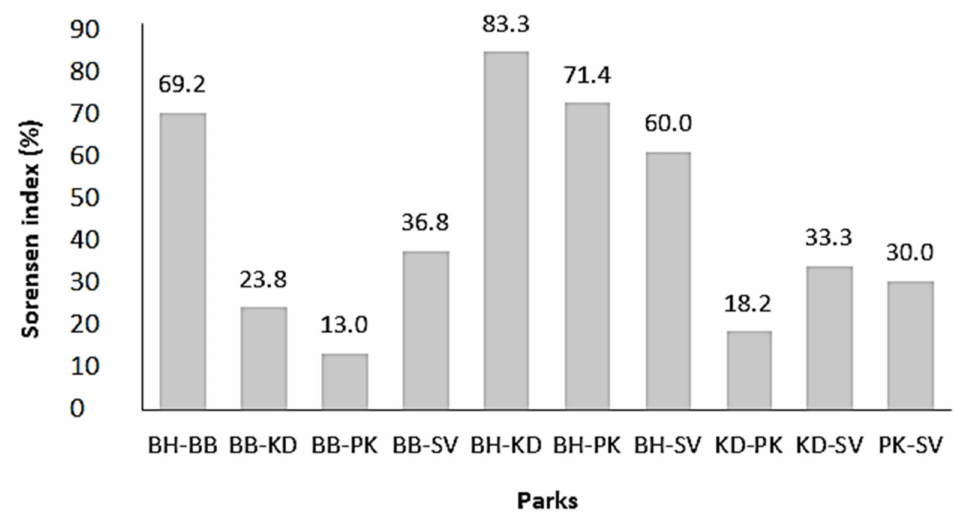
Figure 1. Bar plots showing the pairwise dissimilarity index between the five shea parks.